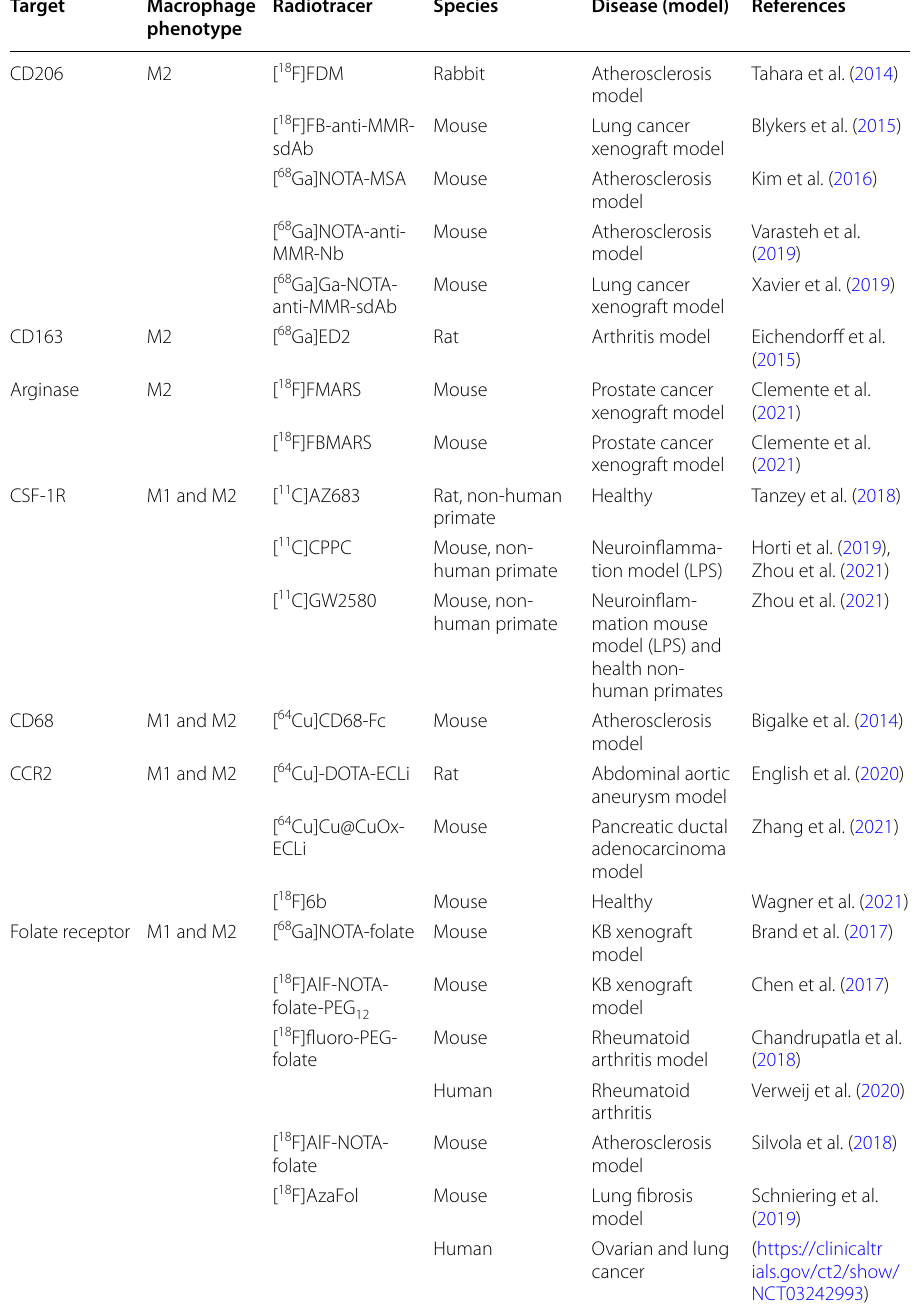
Table 1 Summary of potential PET tracers for TAMs, evaluated in preclinical or clinical